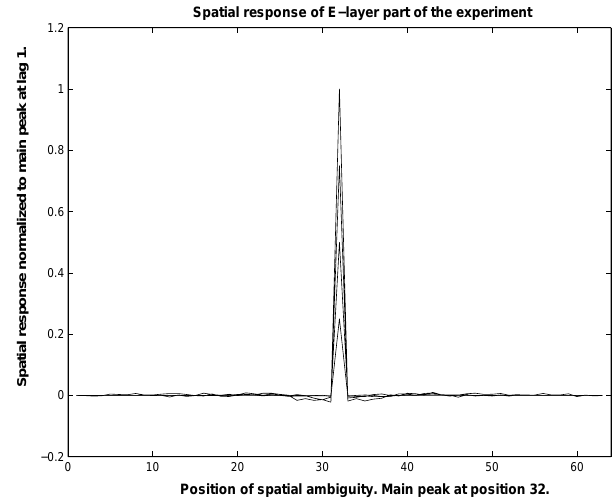
Fig. 2. Spatial response of the E-layer part of the experiment con- taining lag profiles at 32, 64, 96 and 128 µ s.